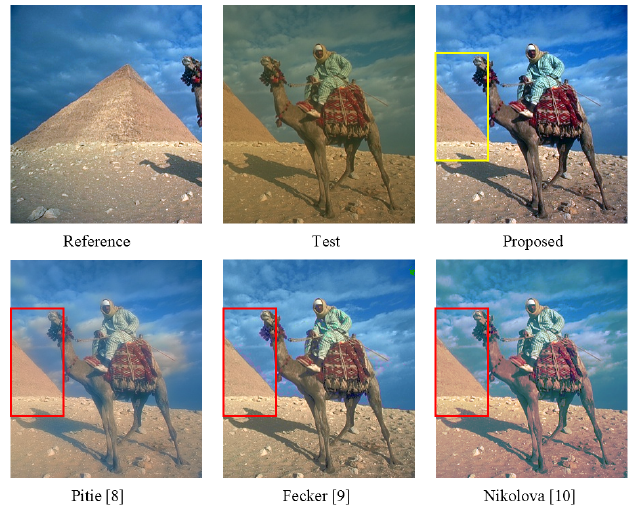
Figure 3. Comparison for the synthetic image pair. Image Source: courtesy of the authors and databases referred on [2,14].